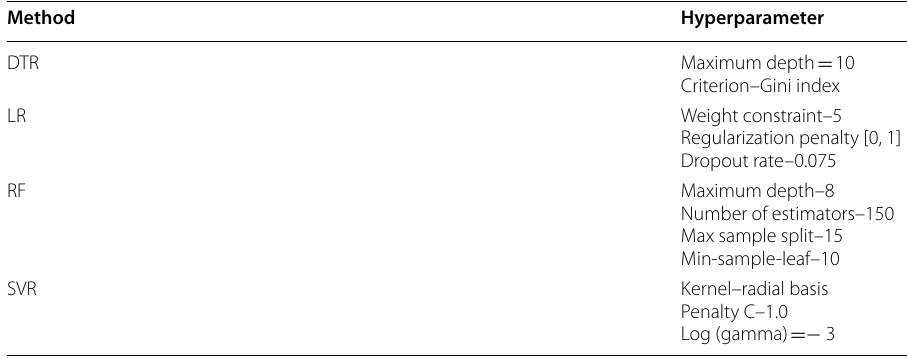
Table 1 Hyperparameters of different